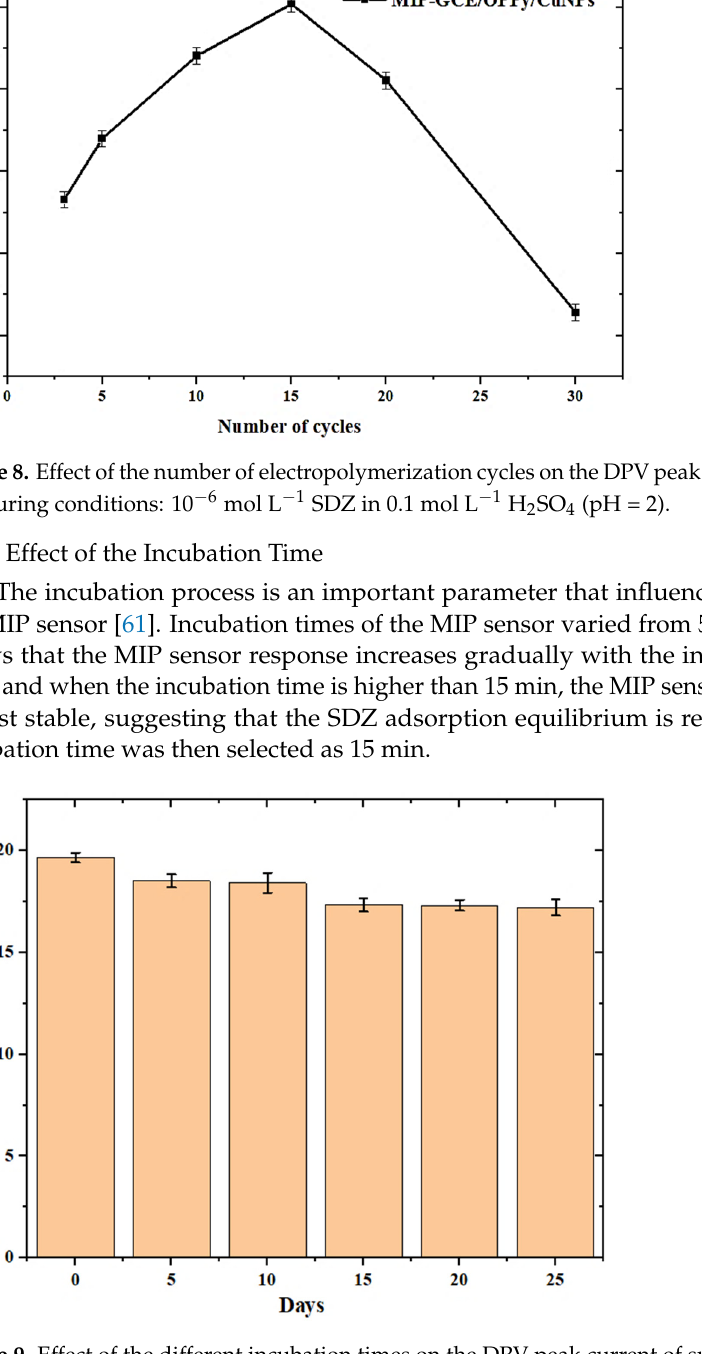
Figure 9. Effect of the different incubation times on the DPV peak current of sulfadiazine. Measuring conditions: 10 − 6 mol L − 1 SDZ in 0.1 mol L − 1 H 2 SO 4 (pH = 2).